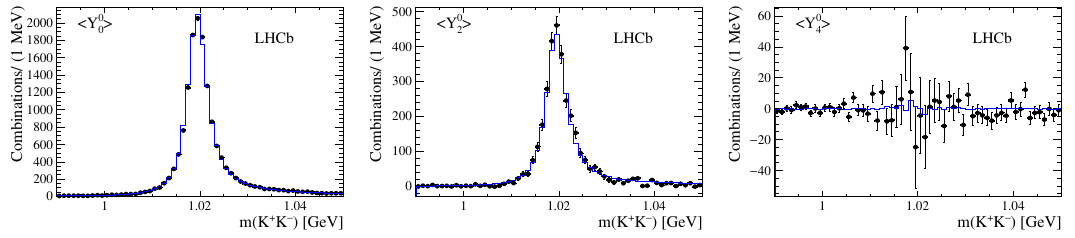
Figure 8 . The K + K (cid:0) mass dependence of the spherical harmonic moments of cos (cid:18) KK in the region of the (cid:30) (1020) resonance after e(cid:14)ciency corrections and background subtraction. The points with error bars are the data points and the (blue) lines are derived from the (cid:12)t model.